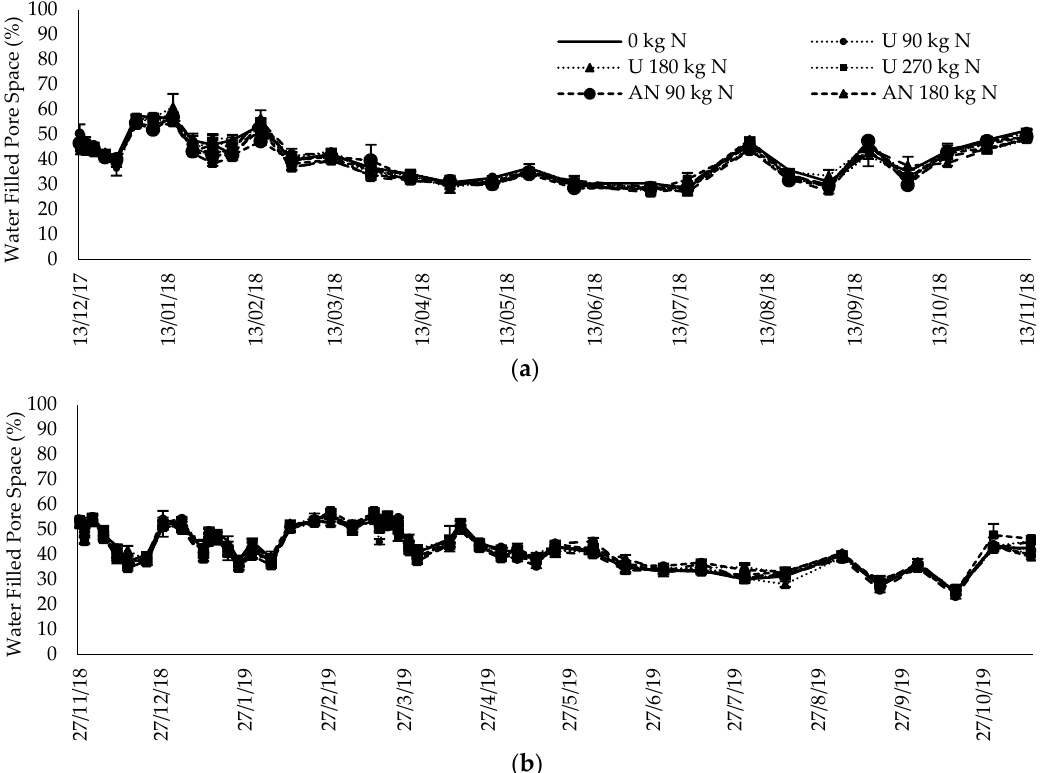
Figure 2. Descriptive averages of water–filled pore space (%) in experiment 1 ( a ) and 2 ( b ).